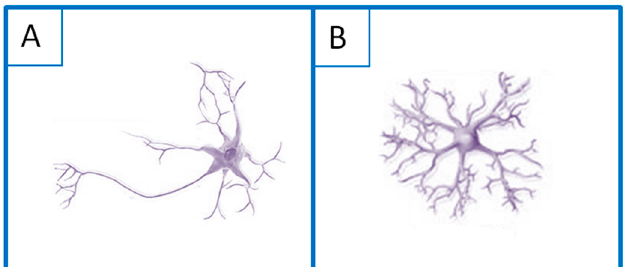
Figure 3. Schematic illustration of the basic units of the nervous tissue: ( A ) neuron and ( B ) neuroglia.